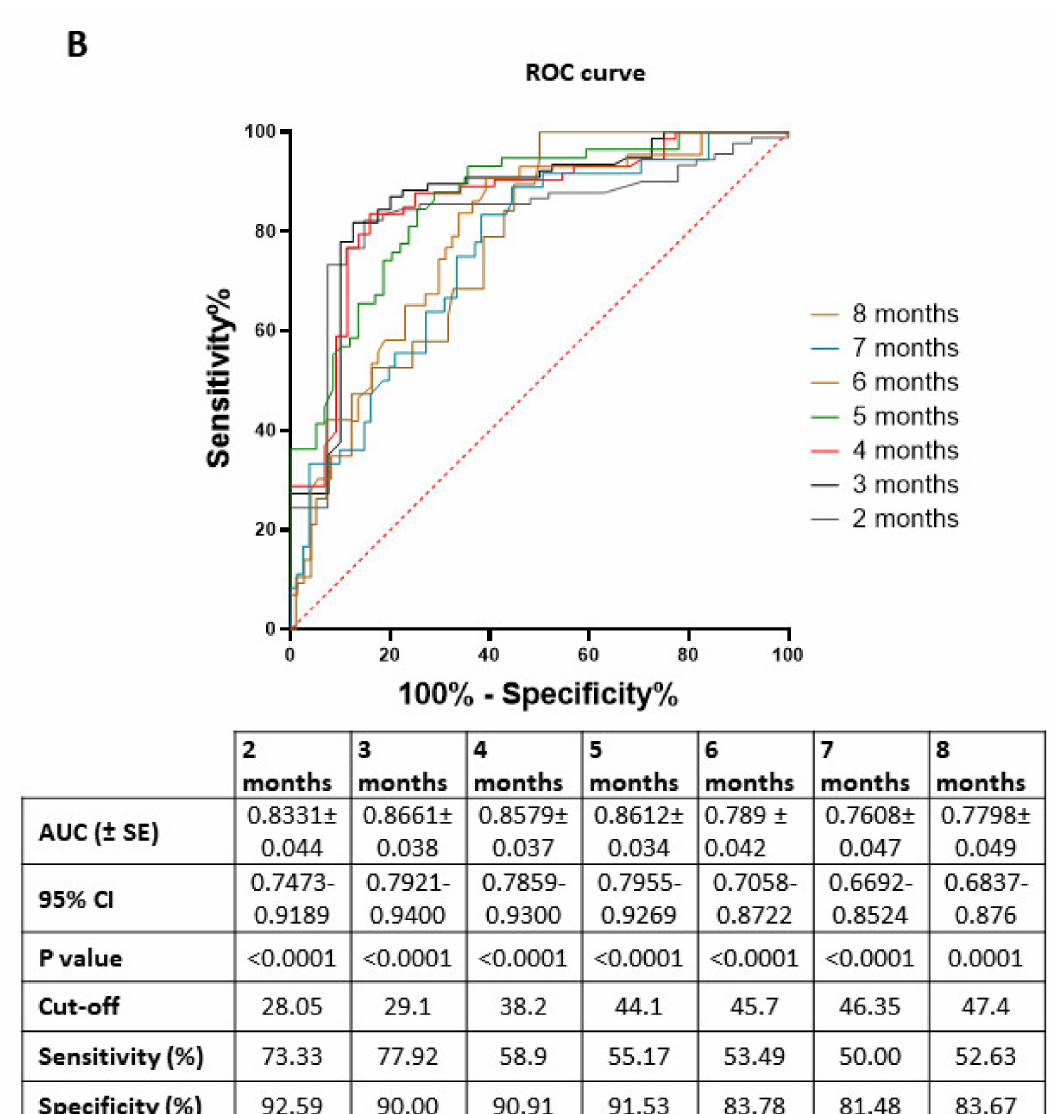
Figure 6. Antibody avidity percentages in COVID-19 patients over time after infection and classifi- cation of time since previous infection. ( A ): Antibody avidity of all patients included in the study (hospitalized or not) were measured at several time-points up to fifteen months. Points at the graph represent the median of avidities at each time-point and error bars indicate the interquartile range (IQR). Horizontal dashed line represents the cut-off value of antibody avidity that has been suggested to differentiate between infections that occurred three or more than three months before sampling. p value indicated on the graph was calculated using Kruskal–Wallis test for all time-points collectively and post hoc analysis of two time-points at a time revealed statistical significance with **** p < 0.0001. ( B ): ROC curves were created to identify the time-point discriminating between recent and past infection, by comparing avidity values of samples collected before and after two (grey line), three (black line), four (red line), five (green line), six (orange line), seven (blue line), and eight months (brown line). Area under the curve for each ROC curve quantifies the overall ability of the test to discriminate between those individuals that were infected before or after the time-point we used as a distinguishing factor. Cut-offs for each ROC curve that exhibit the best combination of sensitivity and specificity were